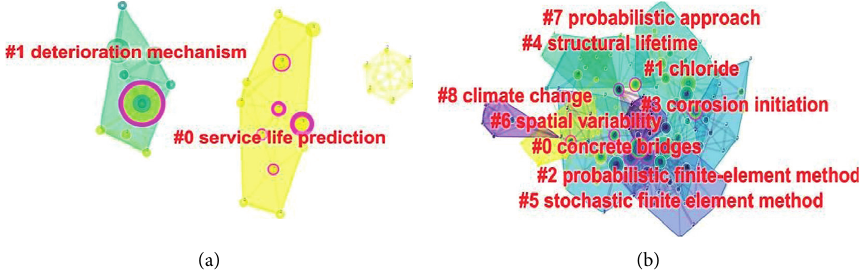
Figure 2: Cluster analysis on the research focus at different stages. (a) Initial development stage. (b) Rapid development